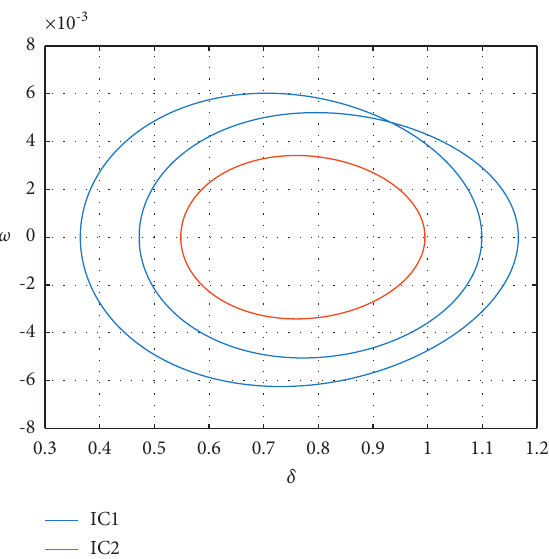
Figure 8: Phase portrait for fractional-order power system (10) at � 0 . 956 under two different initial conditions. P m